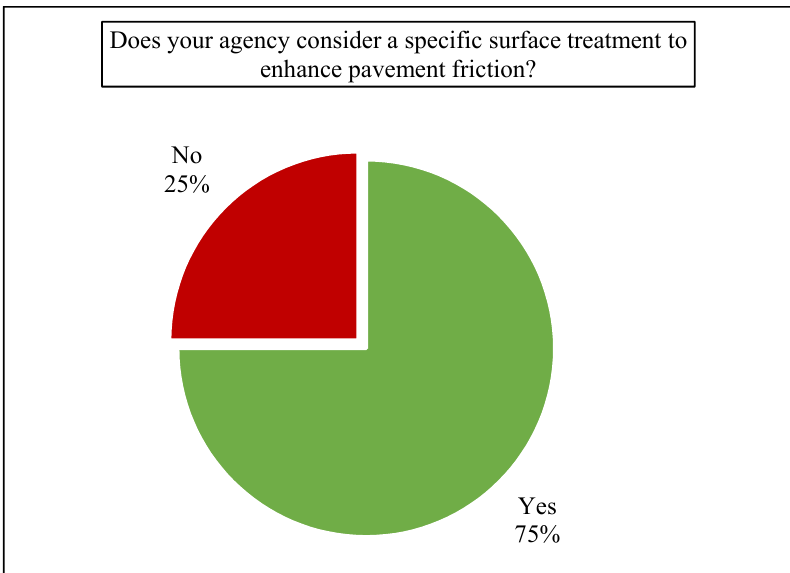
Figure 6. State DOTs feedback of about the pavement friction treatment practice.